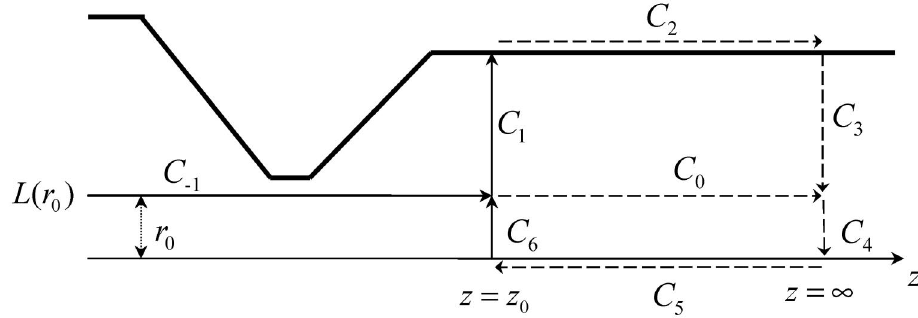
FIG. 2. Contours for the indirect